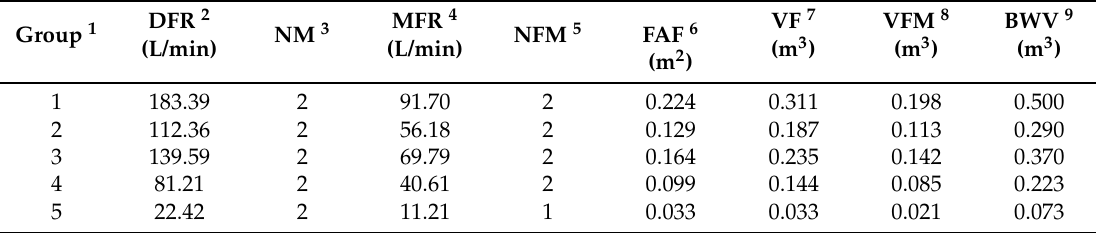
Table 4. Characteristics of the deep bed filters to treat rainwater of Monterrey Campus.